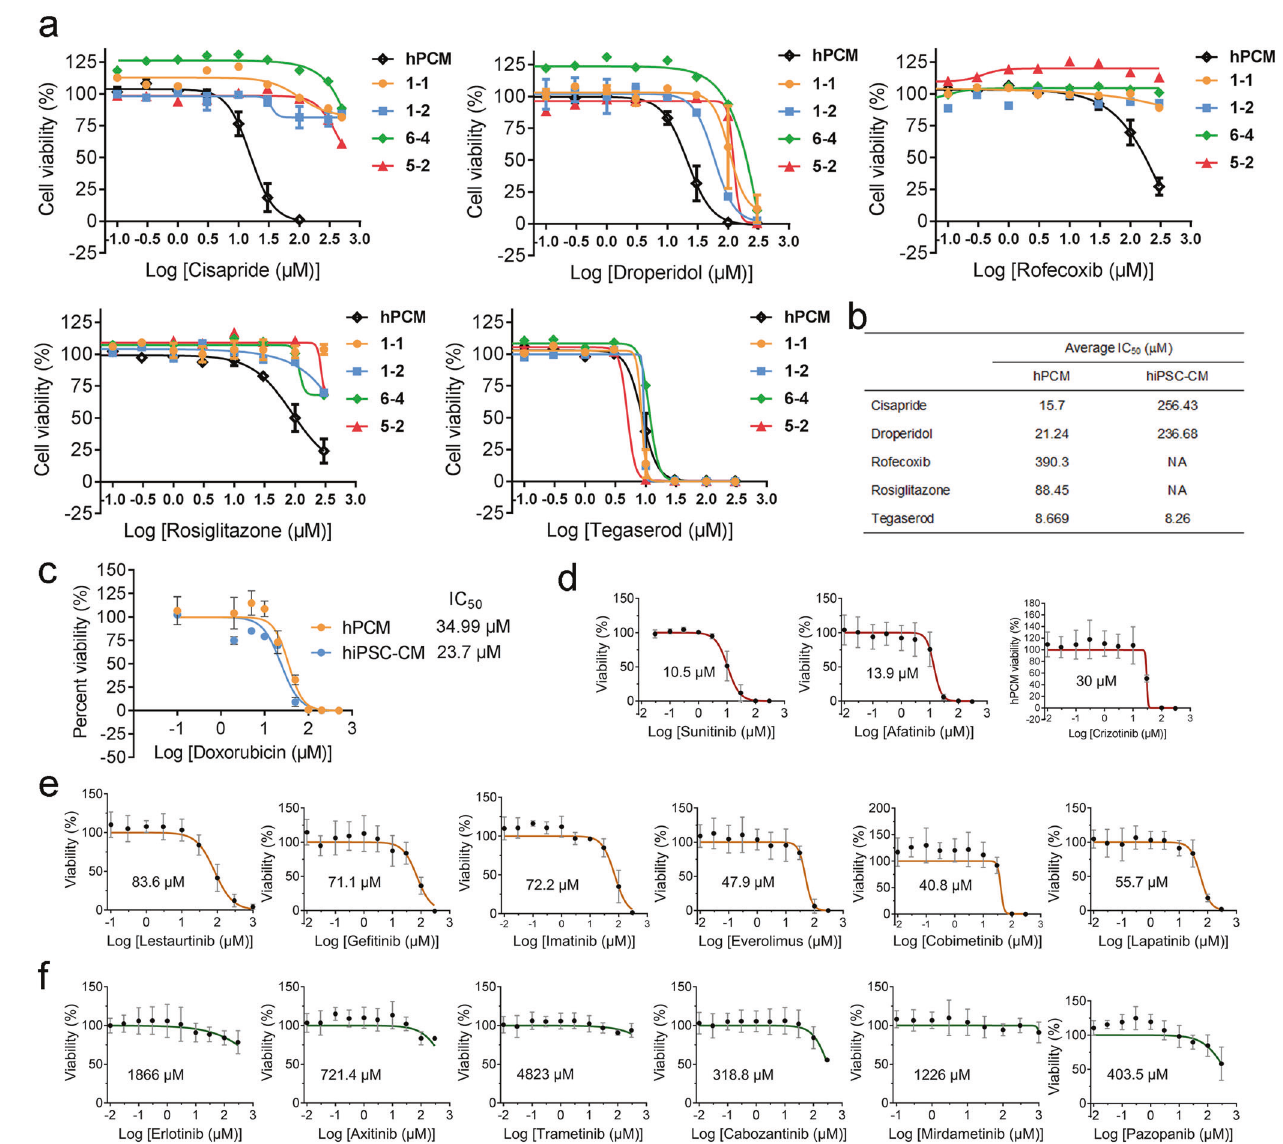
Fig. 6 Cardiotoxicity screening of targeted therapies in hPCMs. a Dose-response curves based on cell viability assays of drugs in hPCMs (black line) and hiPSC-CMs (colored lines). Each drug was tested with hPCMs from fi ve different patients, and hiPSC-CMs from four different hiPSC clones (1-1, 1-2, 6-4, 5-2). b IC 50 values of drugs in hPCMs or hiPSC-CMs. NA represents cases where an IC 50 could not be determined. c Doxorubicin cytotoxicity in hPCMs and hiPSC-CMs from the same patient. d – f Cardiotoxicity screening of 15 kinase inhibitors of different toxicity levels: high toxicity (sunitinib, afatinib, and crizotinib) ( d ), medium toxicity (lestaurtinib, ge fi tinib, imatinib, everolimus, cobimetinib, and lapatinib) ( e ), and low toxicity (erlotinib, axitinib, trametinib, cabozantinib, mirdametinib, and pazopanib) ( f ). n = 5 biological repeats for each